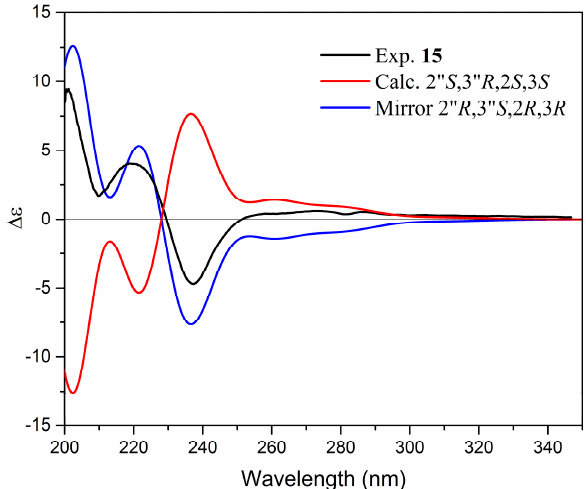
Figure 6. Comparison of experimental and calculated electronic circular dichroism (ECD) spectra of 15 .